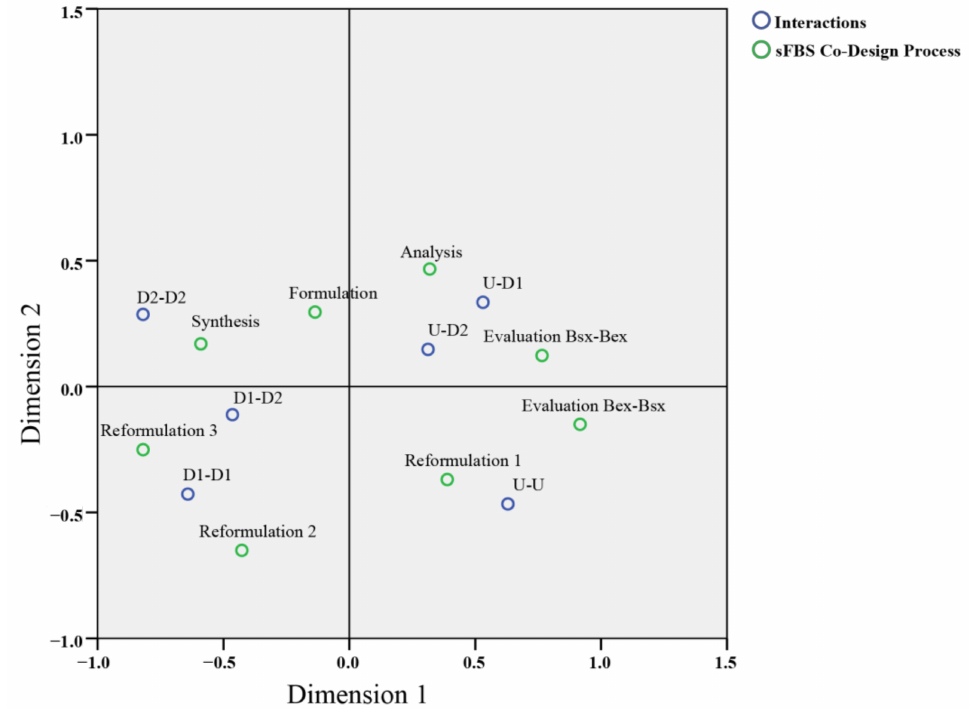
Figure 7. The results of the correspondence analysis between the situated FBS co-design processes and interaction patterns among U-Target User, D1-Designer 1 and D2-Designer